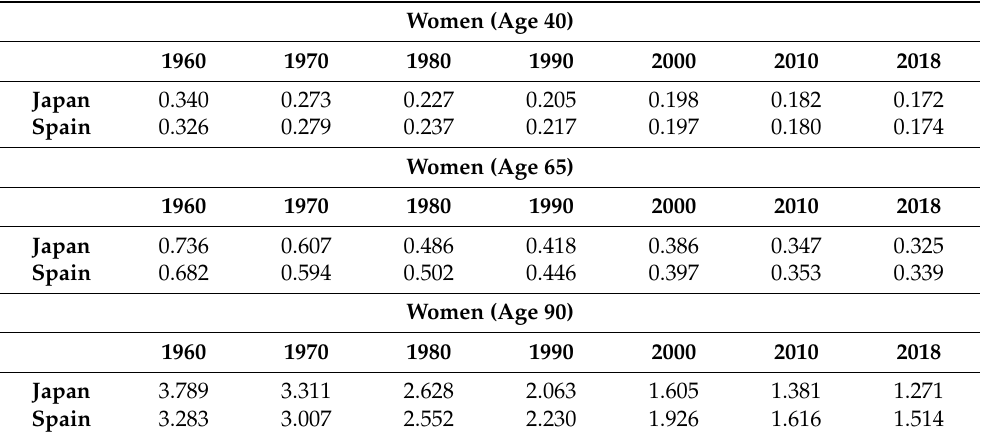
Table 5. Entropy values for the female population for Japan and Spain, for three specific ages: 40, 65, and 90 years old, and for different calendar